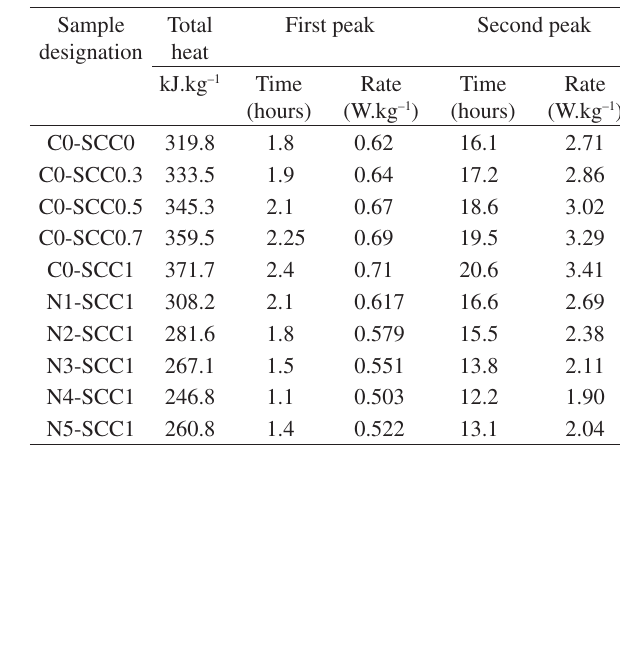
Table 6. Calorimetric results of C0-SCC and N-SCC specimens.